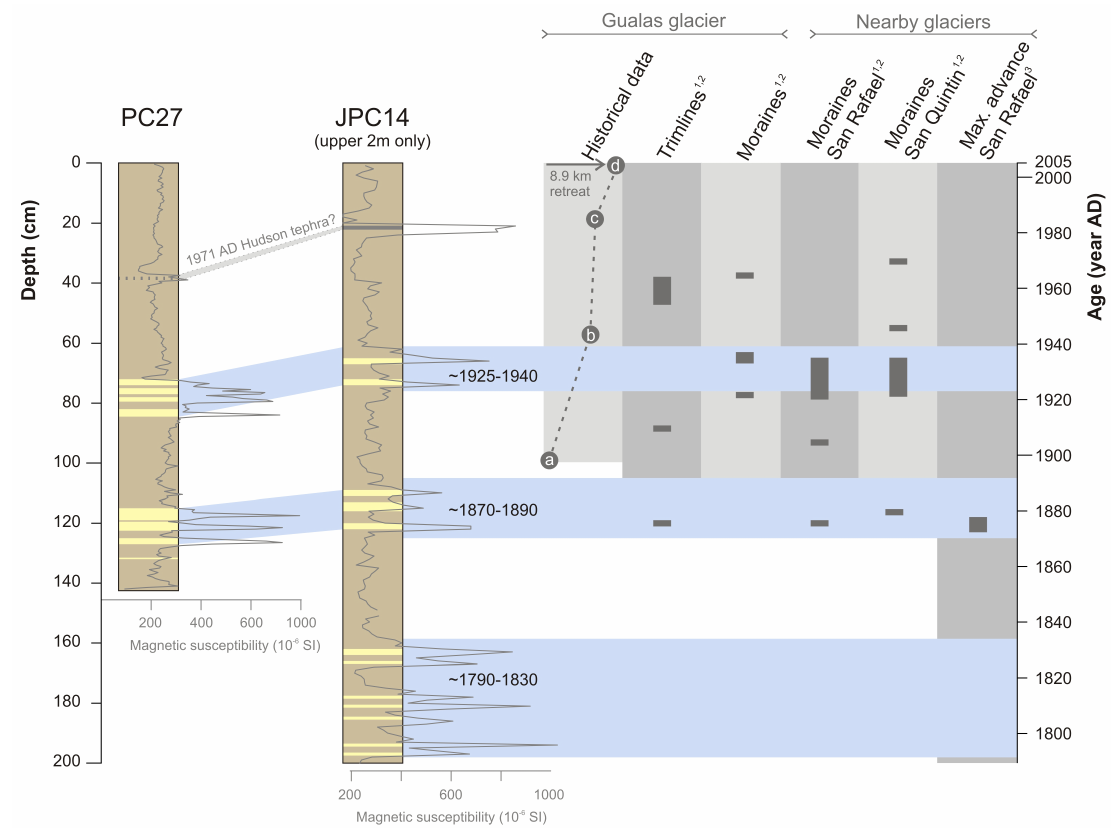
Fig. 9. Lithology and magnetic susceptibility (MS) of sediment core PC27 and of the upper 2m of core JPC14. The results show the presence of several thin silt layers characterized by high MS values at ∼ 1790–1830AD, ∼ 1870–1890AD, ∼ 1925–1940AD. No such silt layers occur below 2m depth. The lithological legend is indicated in Fig. 2 and the age scale corresponds to core JPC14. The right-hand side of the figure summarizes the historical and previously-published results that document recent fluctuations of Gualas and nearby glaciers. For Gualas glacier, the historical data are from: (a) Steffen (1910); (b) Trimetrogon flight (1944); (c) Aniya (1988); (d) Landsat (2010). Previously-published results are from: 1 Harrison and Winchester (1998); 2 Harrison et al. (2007); 3 Araneda et al. (2007). The length of the vertical gray areas represents the maximum length of the